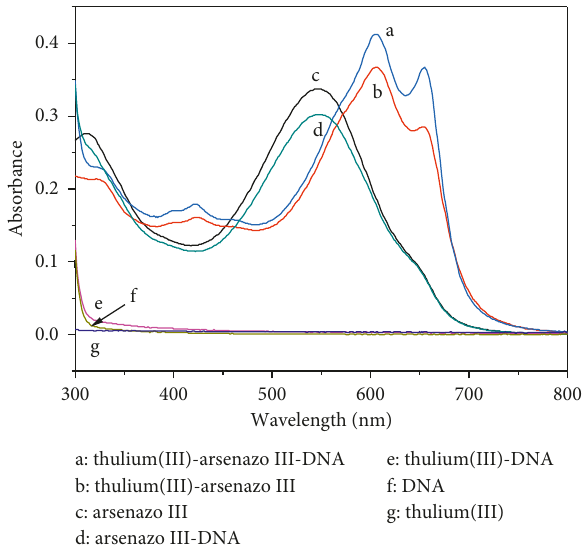
IIIa: thulium(III)-arsenazo III-DNA IIIb: thulium(III)-arsenazo c: arsenazo Figure 2: Absorption spectra of seven kinds of samples (pH